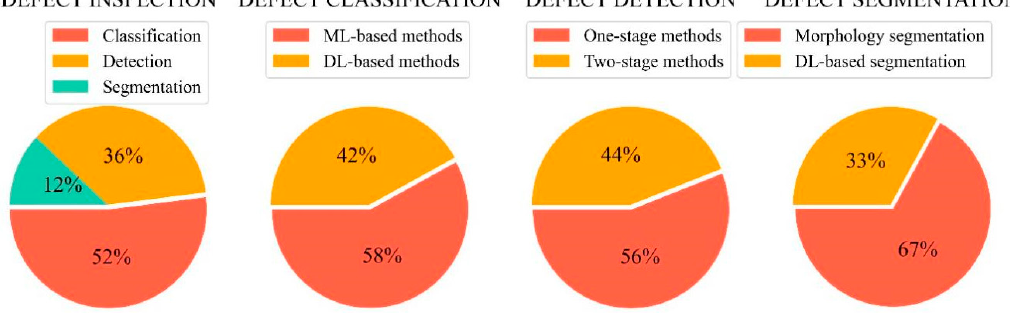
Figure 5. Proportions of the investigated studies using different inspection algorithms.